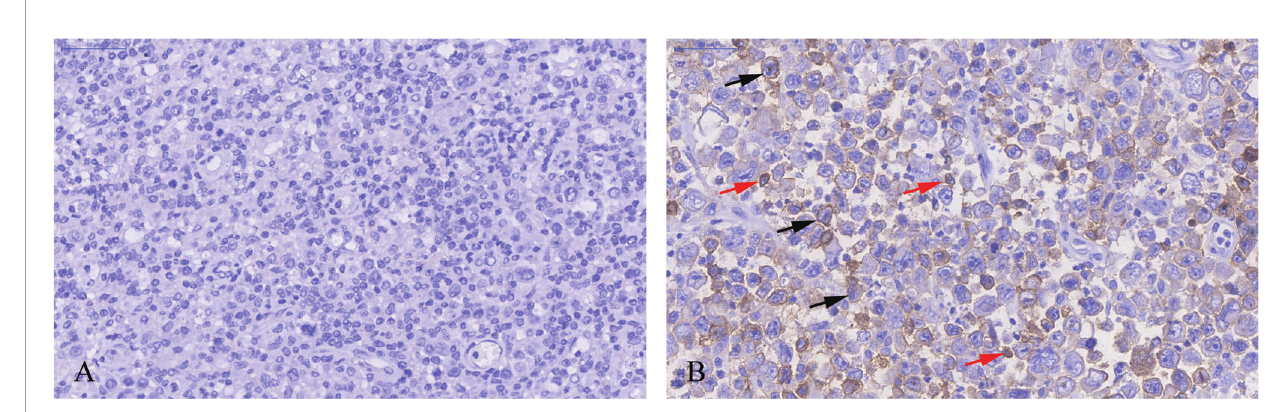
FIGURE 1 | Immunohistochemistry staining of PD-L2 in DLBCL. (A) PD-L2 negative staining (magni fi cation ×40). (B) PD-L2 positive staining (magni fi cation × 40). In (B) , arrows indicate PD-L2 expression on TCs (black arrows) and ICs in the TME (red